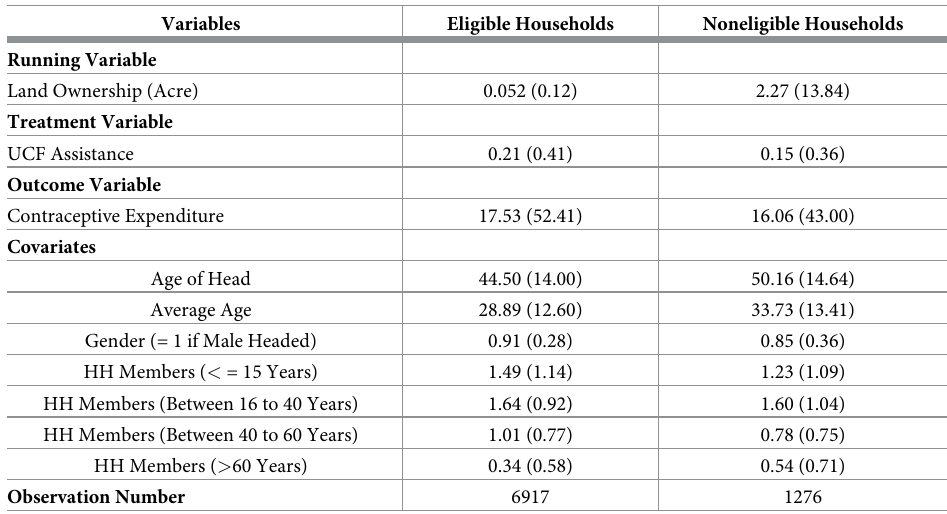
Table 1. Summary statistics of variables in this